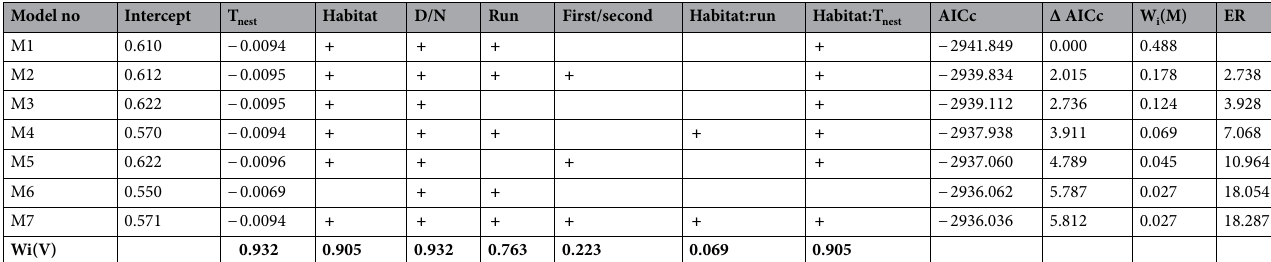
Table 2. The top ranked candidate linear mixed models evaluating the relationship between habitat type and covariates on RMR of Eurasian red squirrels. The models M1 to M6 sum up to a cumulative Akaike weight of 0.95 (= 95% confidence set). Parameters included in the model are indicated by “ + ”. AICc, Akaike’s information criterion, corrected for multiple parameters and small sample size; ΔAICc, differences in AICc; W i (M), Akaike weights per model, variate weights (W i (V)) for all predictors were calculated by summing up Akaike weights of the models containing the respective predictor; ER, evidence ratio; T nest , nest box